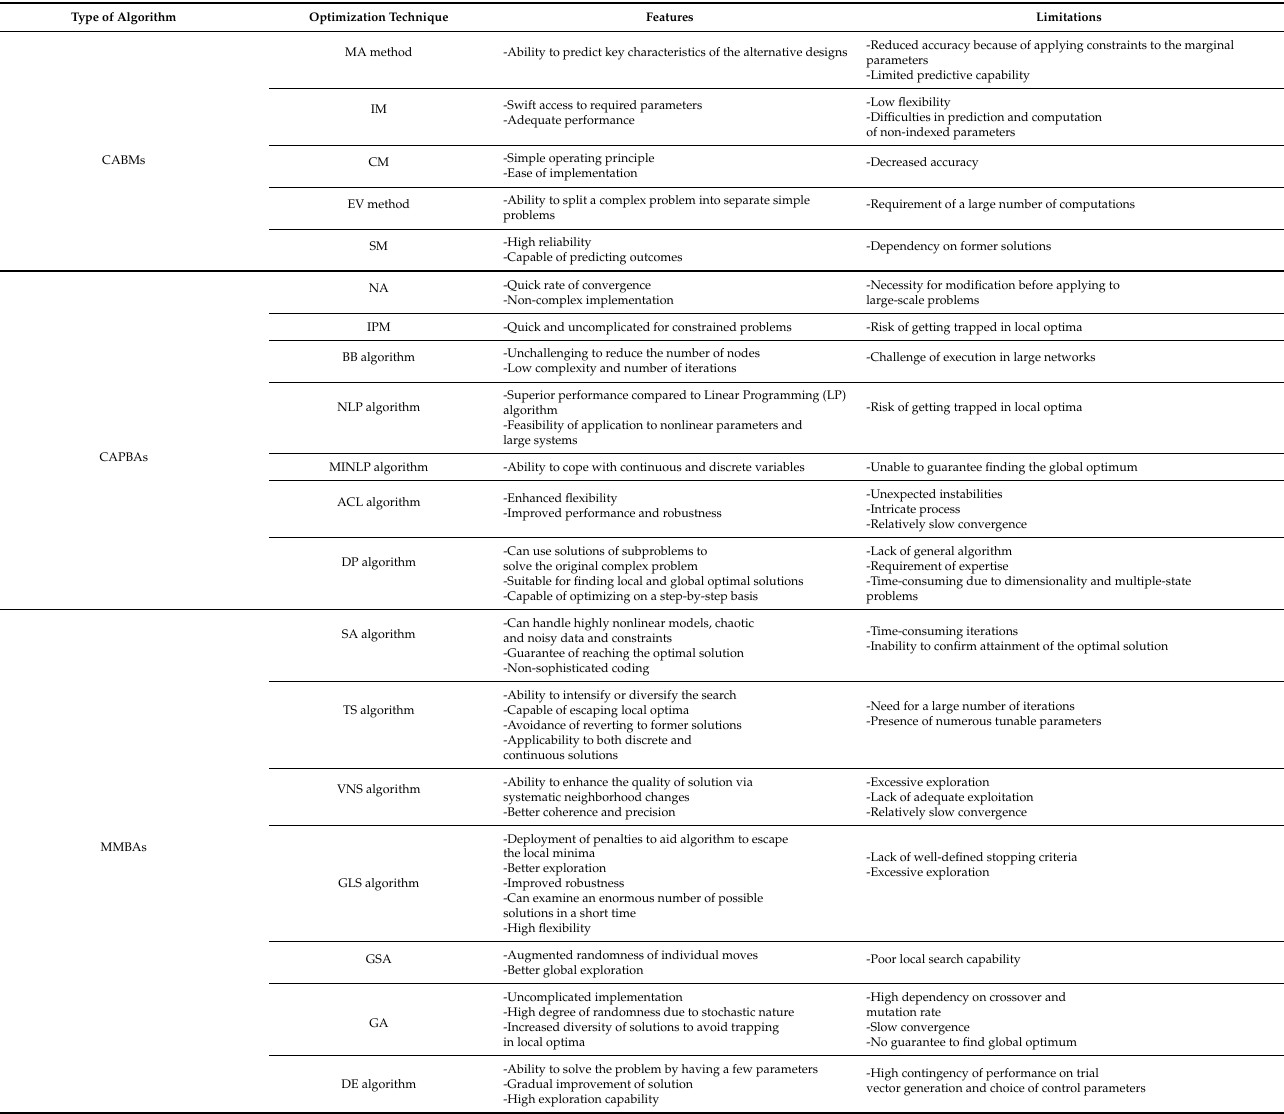
Table 2. Comparative analysis of the prevailing optimization